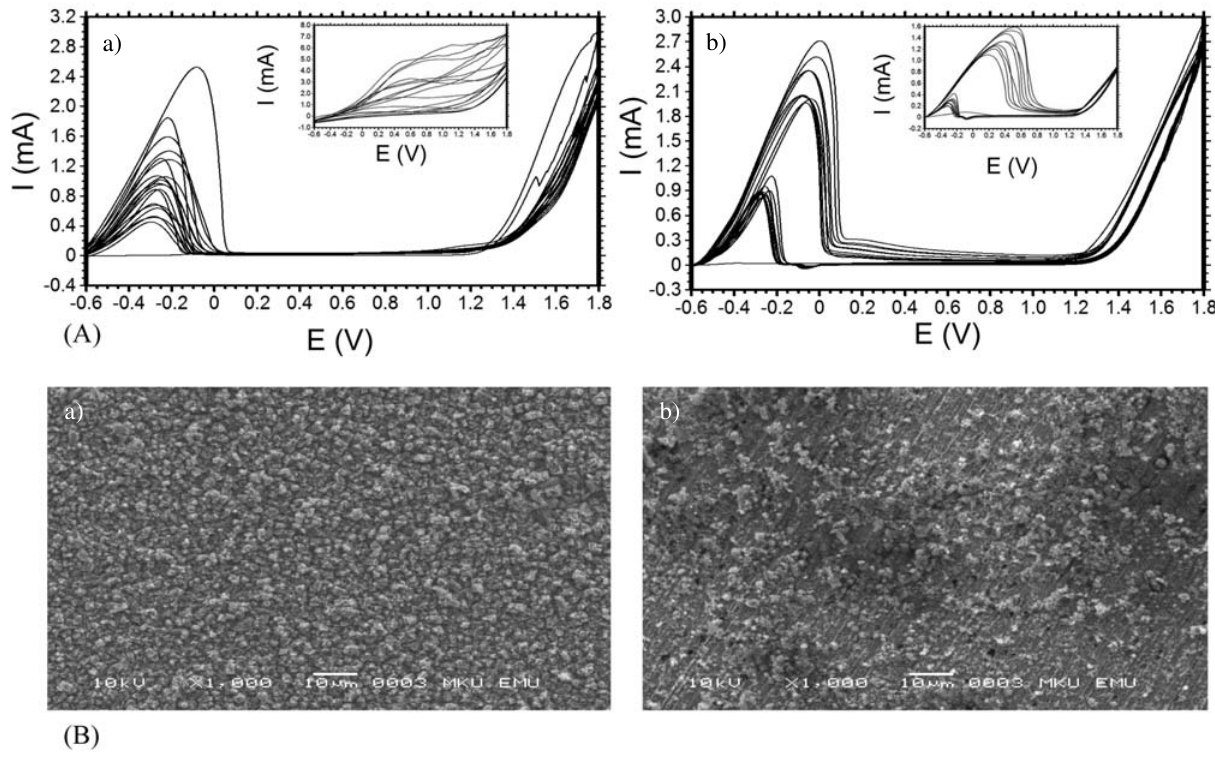
Fig. 3. Film growth curves (A) and SEM images (magnification: 1000) (B) of layers obtained on CS electrode in a) 0.20 M NaOX b) 0.20 M Na- Tart solution, scan rate: 50 mV s –1